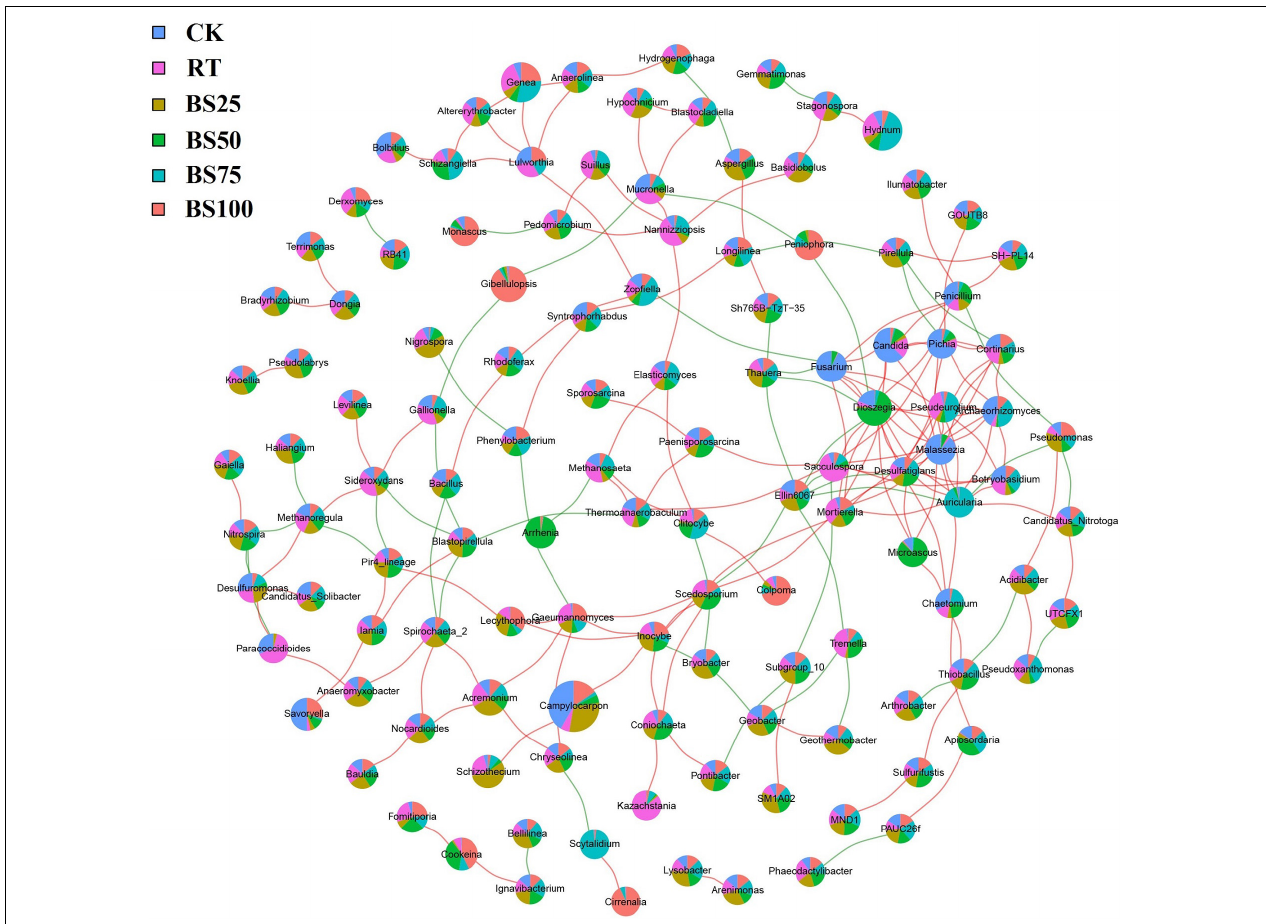
FIGURE 6 | Network analysis based on bacterial and fungal OTUs with the abundance higher than 0.1%. Red and green lines represent significantly positive and negative correlations ( P < 0.01), respectively. Node size is positively related to OTU abundance. Colored proportions of nodes signify OTU abundance in relation to the different